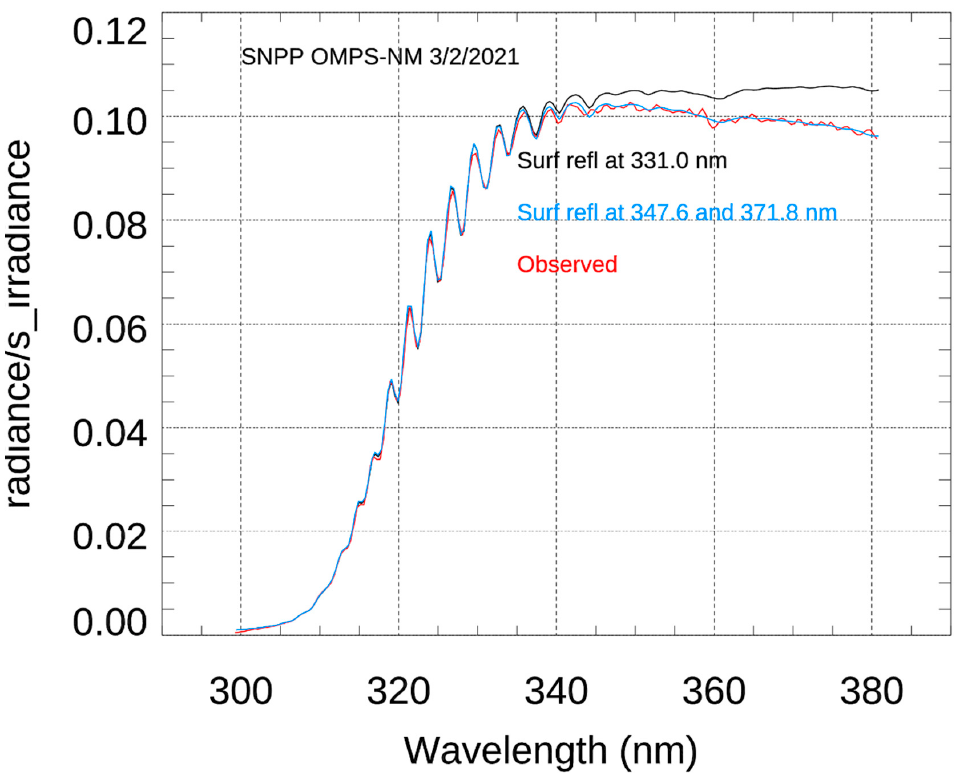
Figure 4. SNPP normalized radiance. Red line represents the OMPS NM measurements. The black line is the CRTM simulation using a constant surface reflectance by fitting the normalized radiance at 331 nm. The cyan line is the CRTM simulation using linearly interpolated/extrapolated surface reflectance from two reflectance by fitting the normalized radiance at 347.6 nm and 371.8 nm.